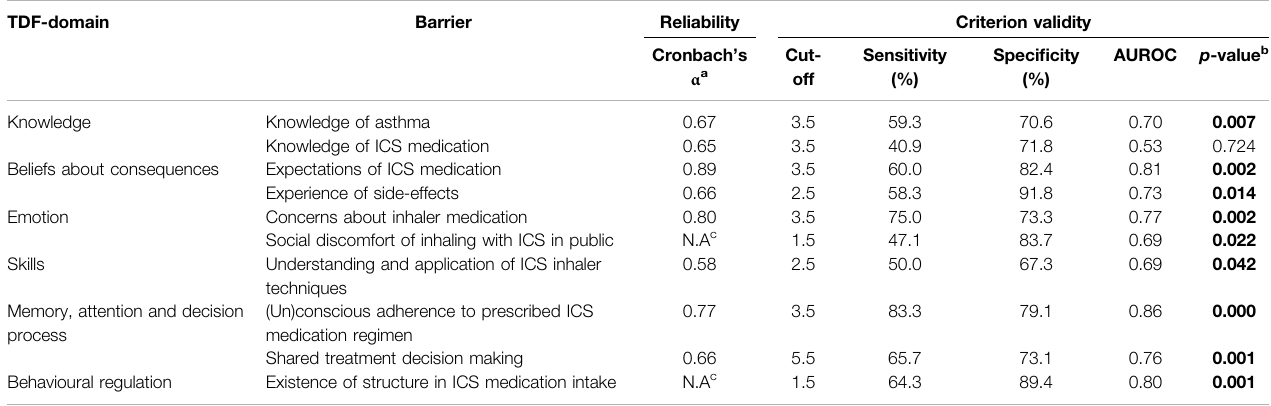
TABLE 3 | Psychometric characteristics of the self-management barriers on the RACE questionnaire. TDF-domain